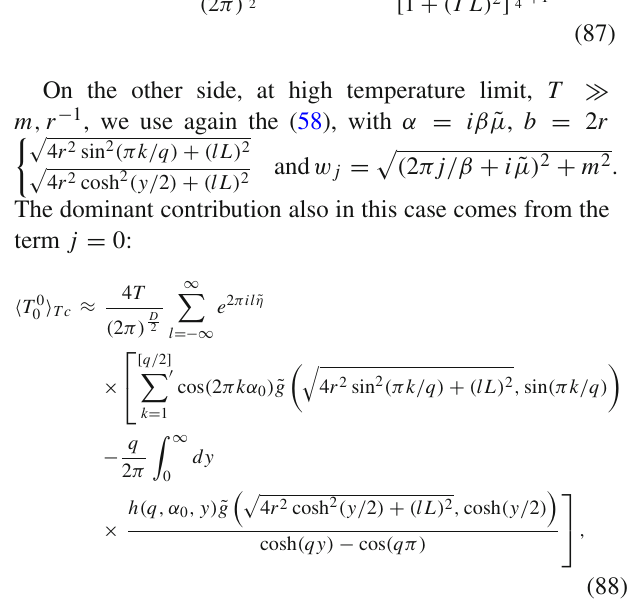
3, for fixed q = 2 . 5, mr = 1, L / m = 1, ξ = 0, | ˜ μ | / m = 0 . 5, ˜ η = 0 . 5 and different values of α